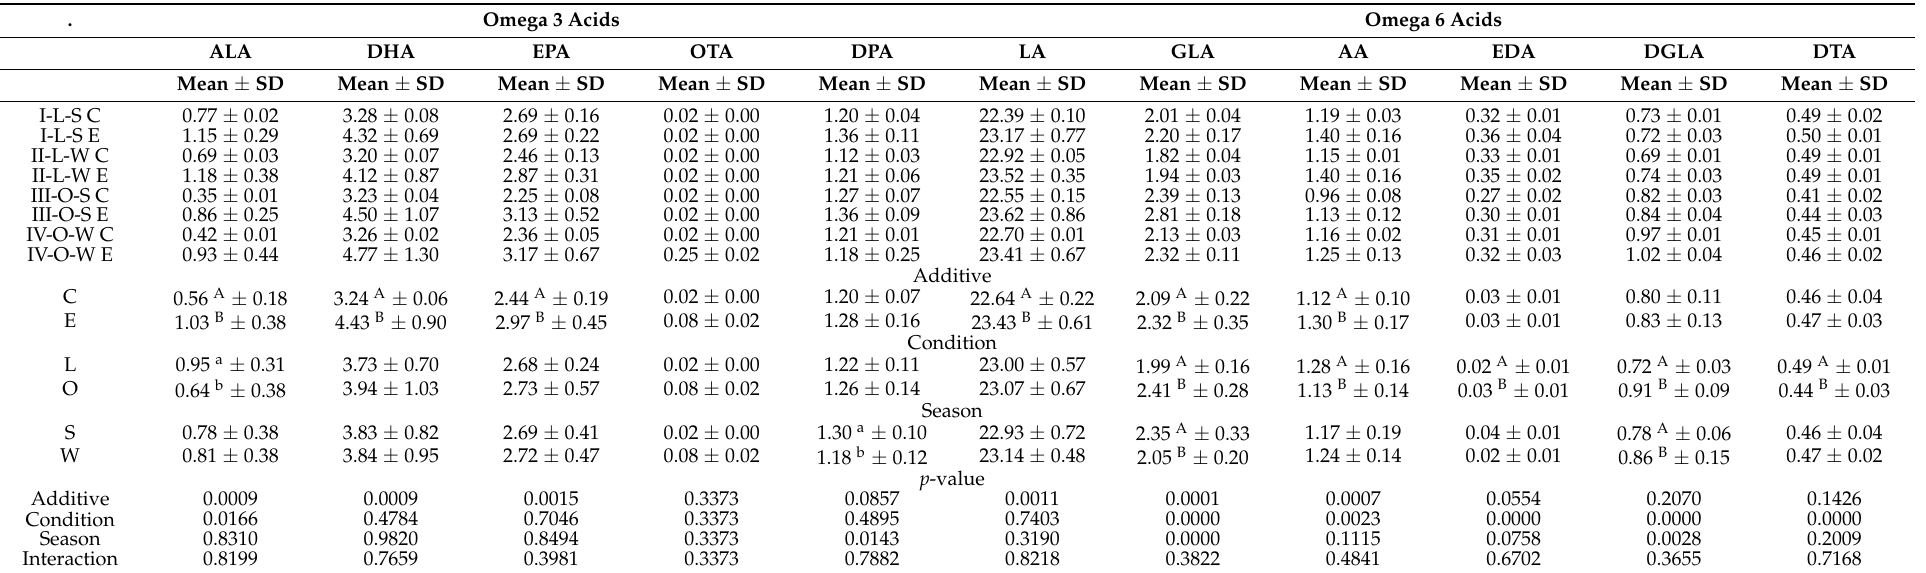
Table 7. Content of omega 3 and omega 6 fatty acids in rabbit blood